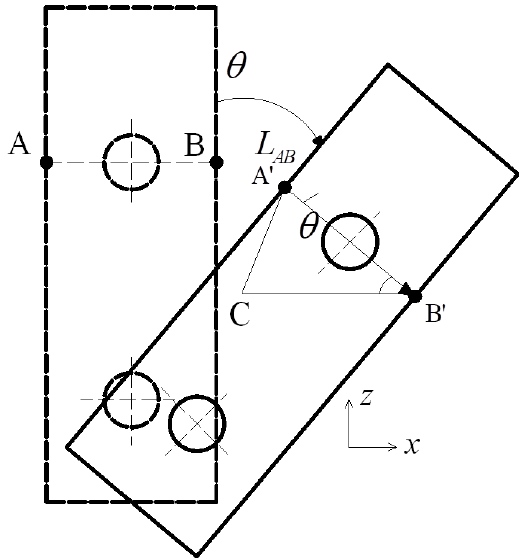
Figure 9: Rotation schematic diagram of